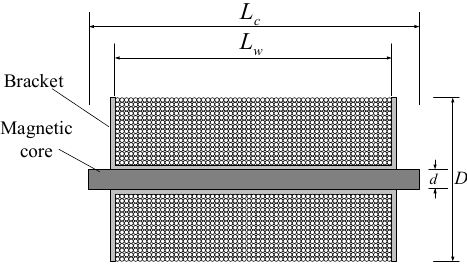
Figure 2. Structure of magnetic core coil sensor.